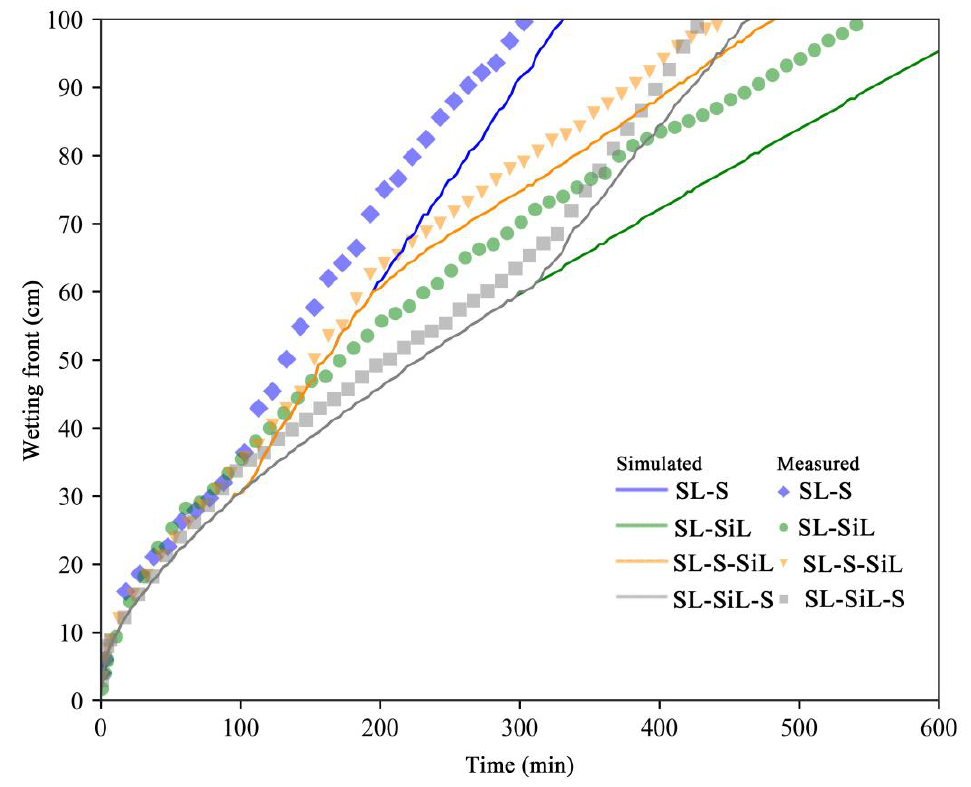
Figure 9. Measured and simulated wetting fronts in the soil columns.